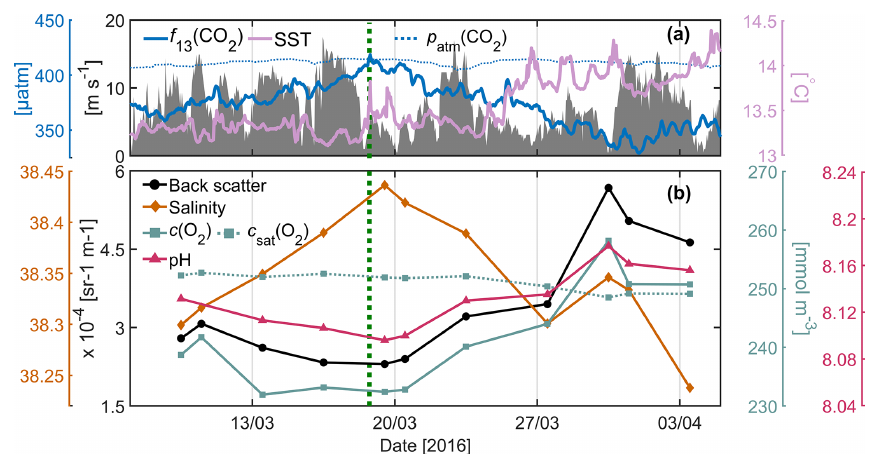
Figure 4. (a) Wind speed at 10m above sea level at the meteorological buoy (dark grey shading), sea surface temperature (pale pink) and CO 2 fugacity normalised to 13 ◦ C (blue) at 10m depth at the BOUSSOLE buoy. The partial pressure of atmospheric CO 2 in March 2016 (dotted blue) at Lampedusa, Italy, is shown. The onset of the spring bloom (dashed green), determined using buoy f ( CO 2 ) measurements, is plotted for comparison. (b) Glider measurements of salinity (orange), optical backscatter at 700nm (black), dissolved oxygen concentrations ( c( O 2 ) ) (turquoise) and calibrated pH T (pink) binned at 10m. The oxygen concentration at saturation (dashed turquoise; parameterisation of García and Gordon (1992) based on Benson and Krause, 1984) is plotted for